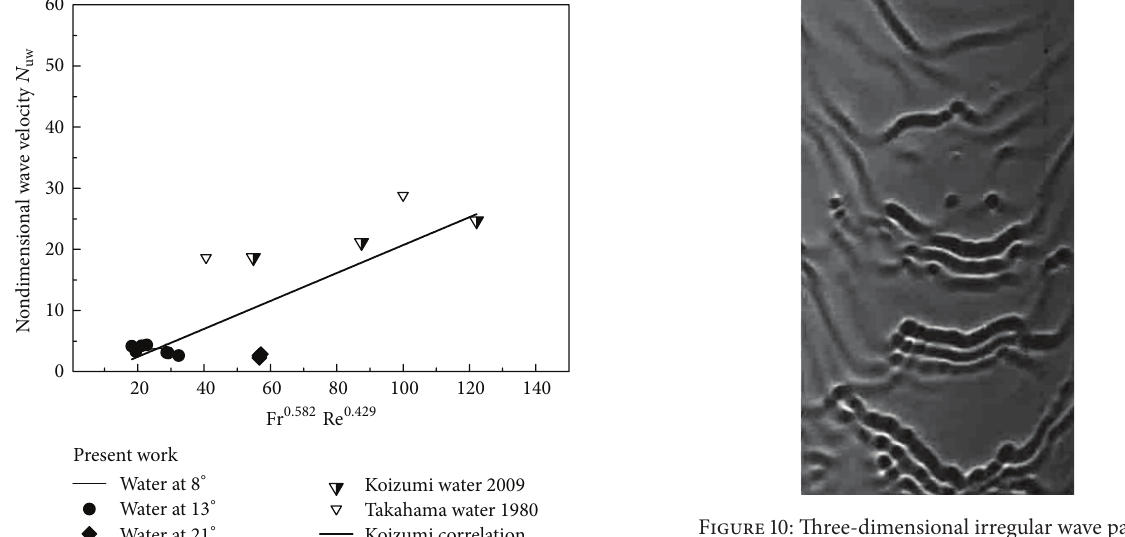
Figure 10: Three-dimensional irregular wave